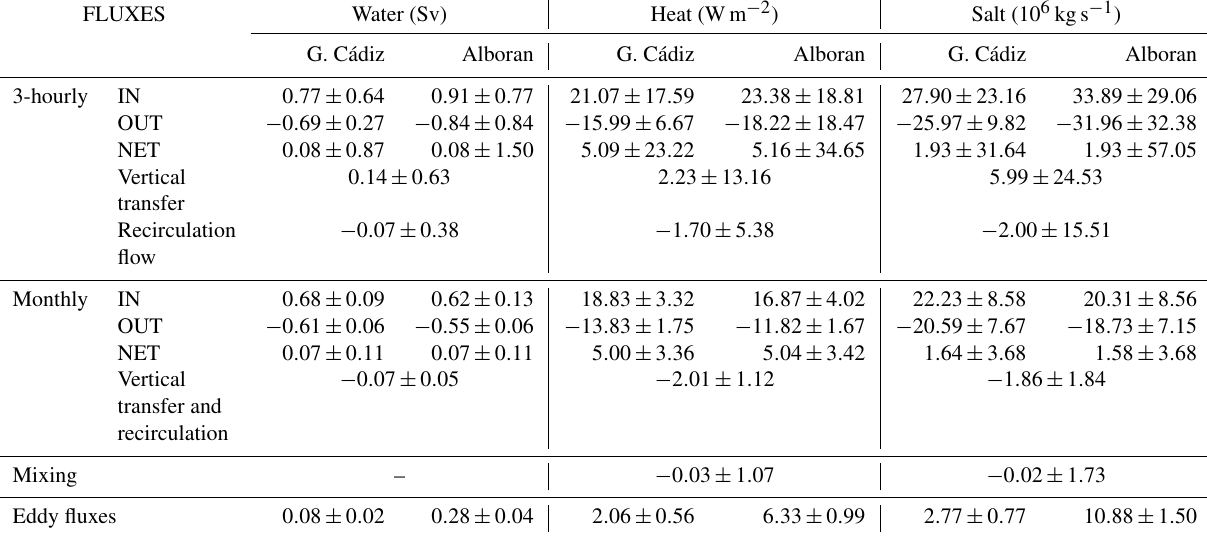
Table 1. Mean values and standard deviations of the horizontal transports of water, heat and salt computed from the tidal run at the outermost cross-strait sections (Gulf of Cádiz and Alboran). The estimated vertical transfer, recirculation fluxes and mixing (see text for details) are also indicated. The results are shown for the 3-hourly data and the monthly